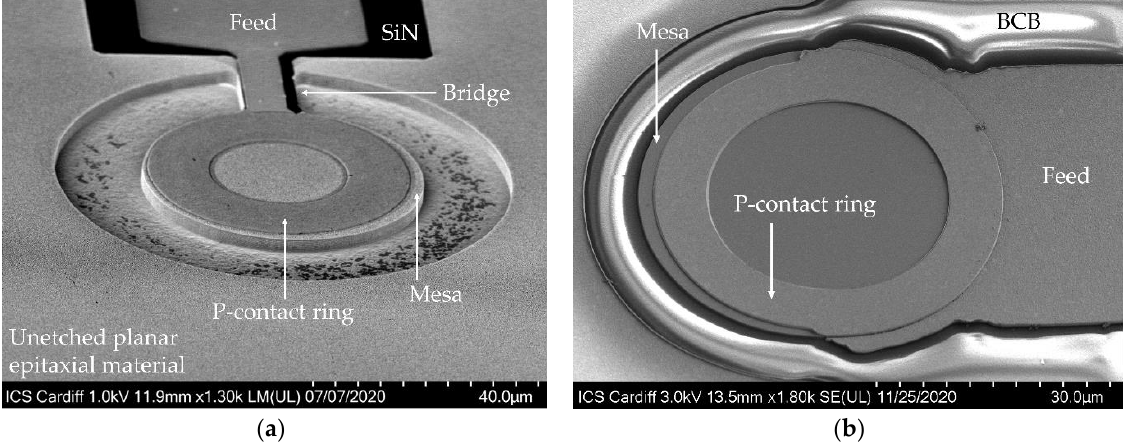
Figure 1. ( a ) SEM Image of a Quick Fabrication (QF) VCSEL; ( b ) SEM image of a standard VCSEL.